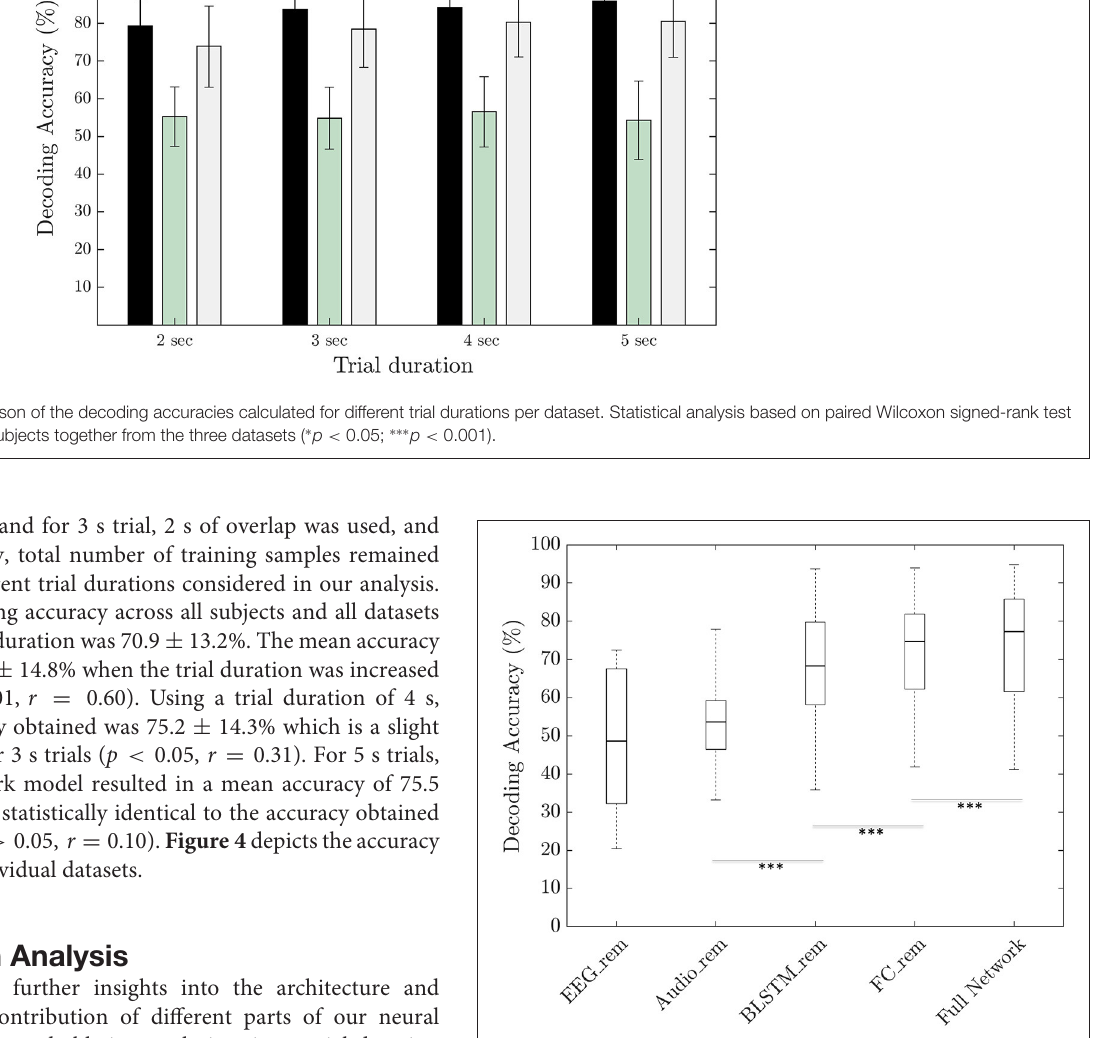
FIGURE 5 | Boxplots showing the decoding accuracies obtained by ablating the different blocks such as FC layer or BLSTM layer. To obtain the test accuracies after ablating, the ablated network was trained from scratch in case of FC_rem and BLSTM_rem. However, in case of Audio_rem and EEG_rem, accuracies were calculated by zeroing out the corresponding input features before passing them to a fully trained network. The obtained accuracy did not demonstrate a statistically significant difference between Audio_rem and EEG_rem ( p > 0.05). For all other cases, there was a significant difference ( ∗∗∗ p < 0.001 based on paired Wilcoxon signed-rank